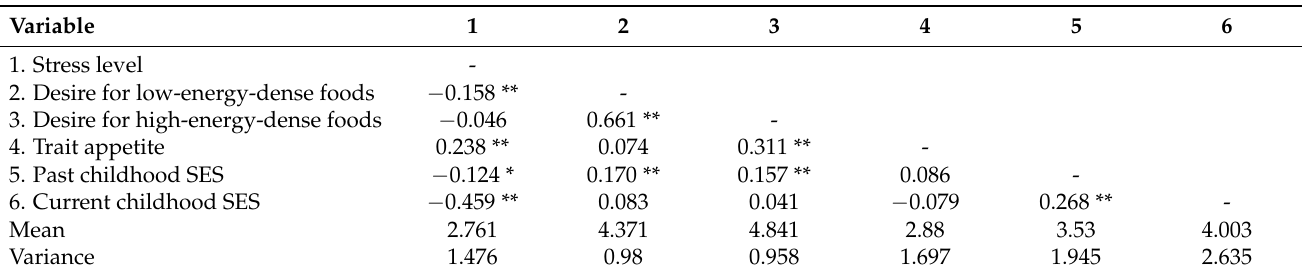
Table 2. Correlations among model constructs.